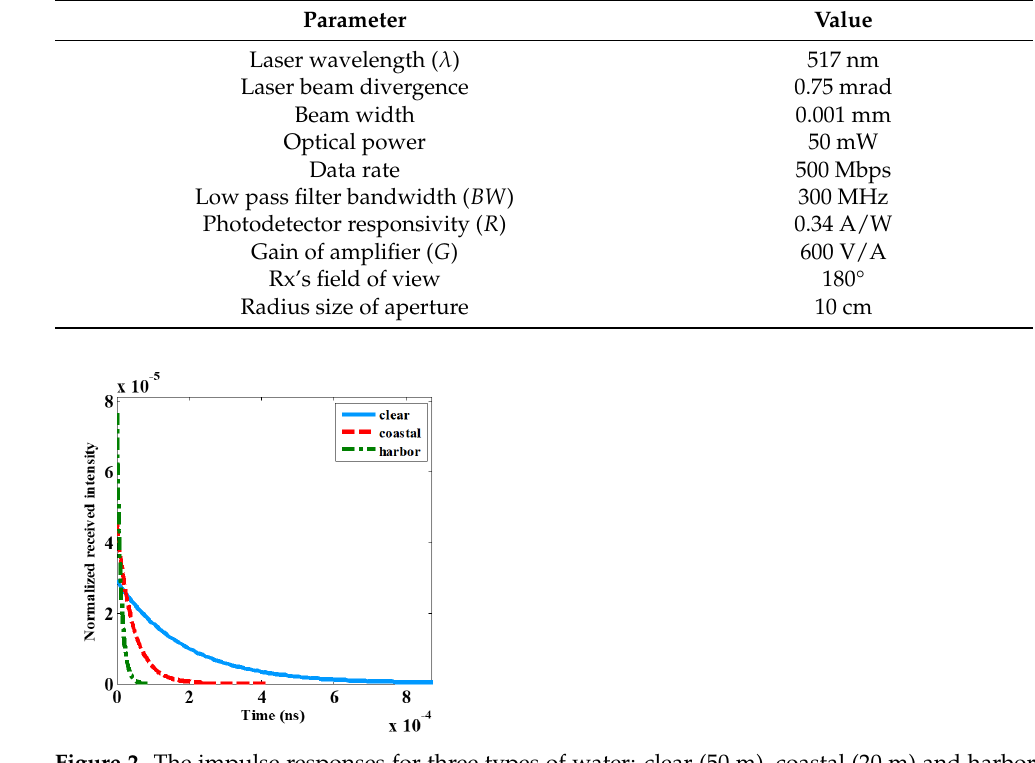
Figure 2. The impulse responses for three types of water: clear (50 m), coastal (20 m) and harbor (4 m).